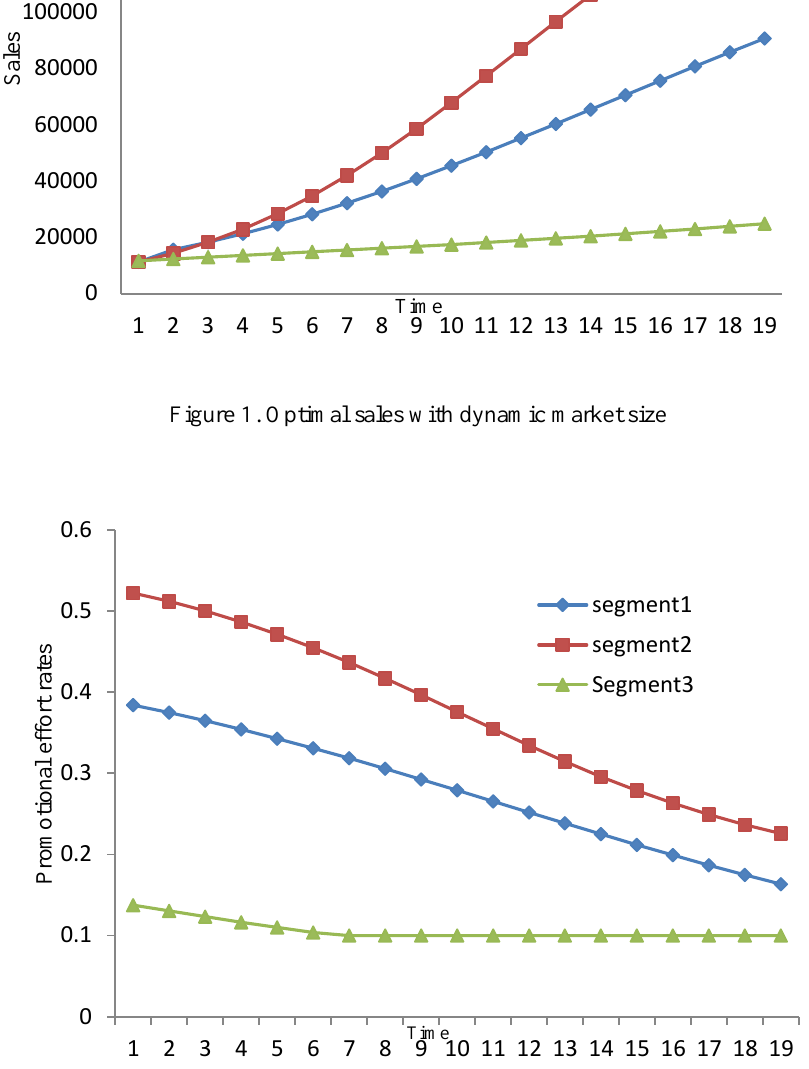
Figure 2. Optimal differentiated promotional allocation with dynamic market